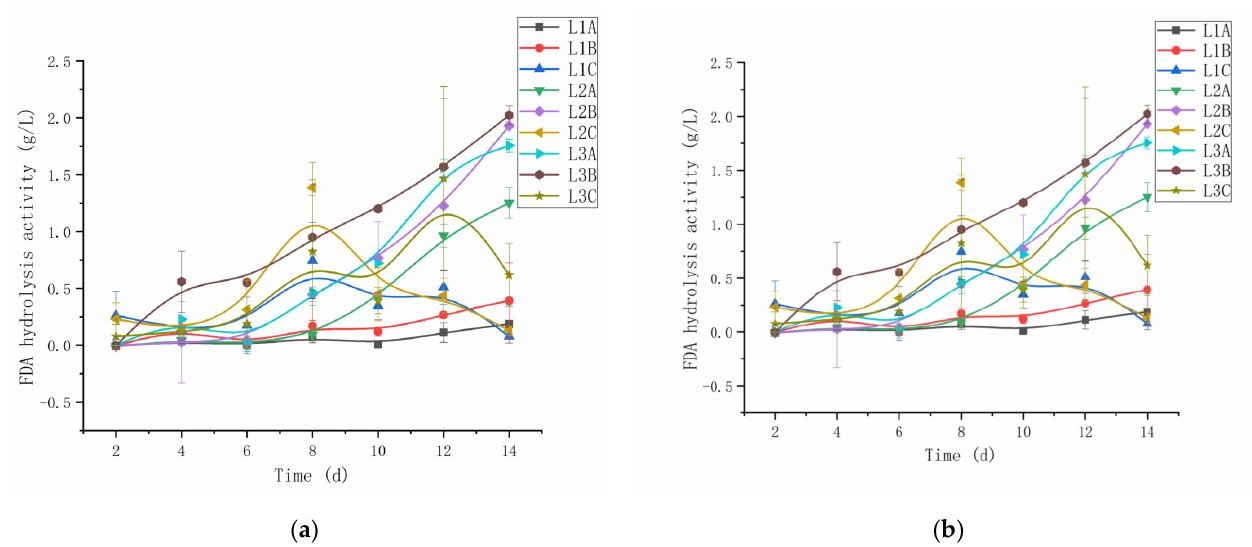
Figure 2. Hydrolytic activity under different treatments during biodegradation within 14 days. ( a ) FDA hydrolytic activity of 0.01 g/L crude oil. ( b ) FDA hydrolytic activity of 10.00 g/L crude oil.